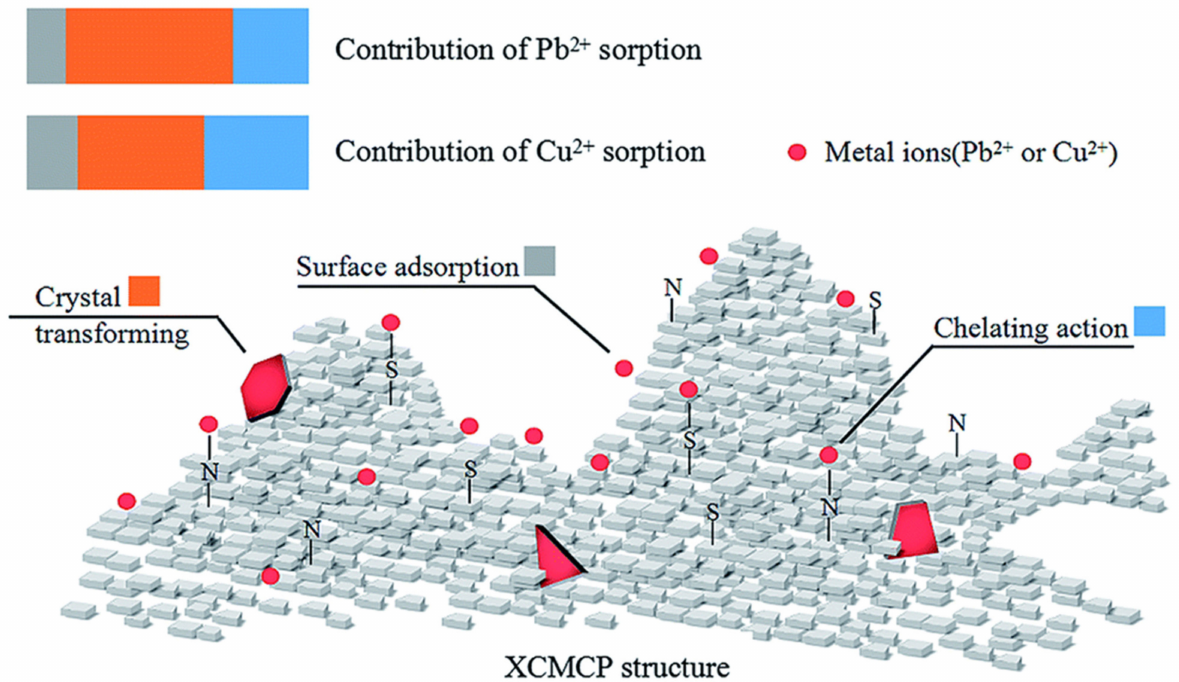
Figure 6. Adsorption mechanism diagram and contributions of adsorption Pb 2+ and Cu 2+ onto XCMCP